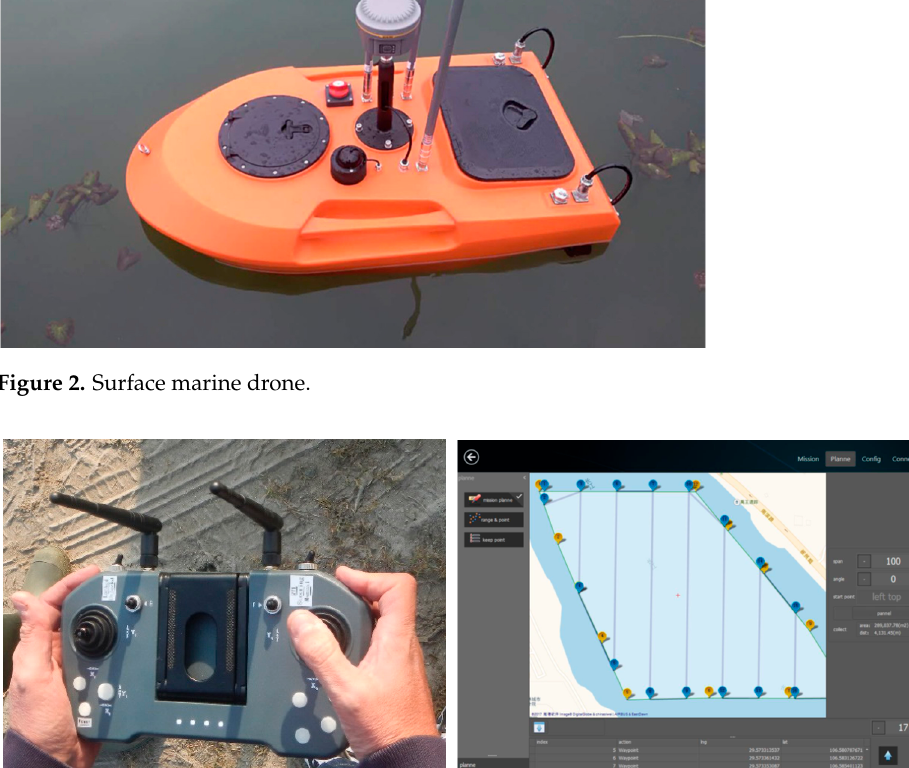
Figure 2. Surface marine drone.